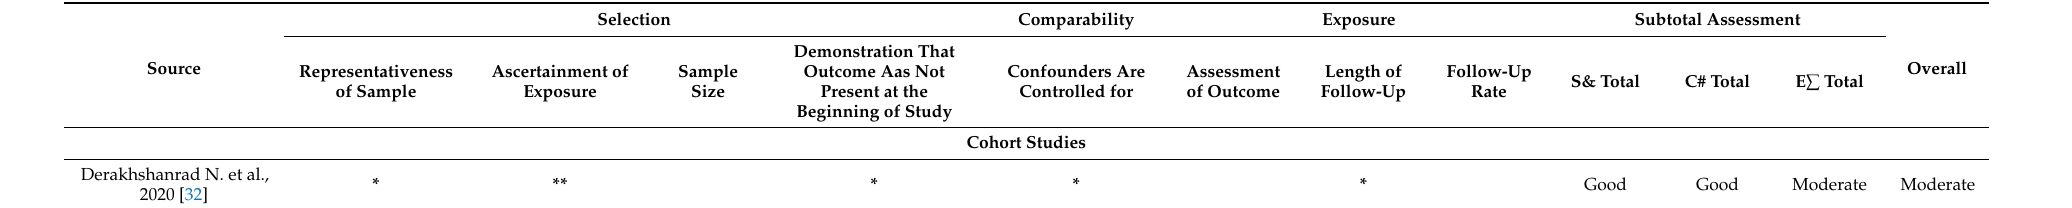
Table 3. Quality assessment of included cohort studies using the Newcastle-Ottawa Scale.